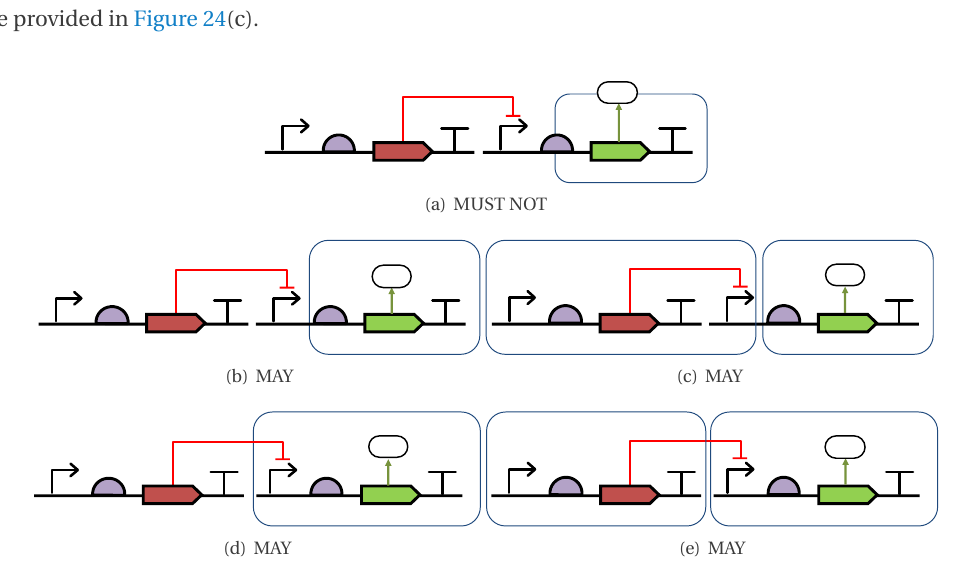
Figure 24: Examples of recommended and problematic boundary intersections: (a) sequence feature and molecular species glyphs MUST NOT intersect a subsystem boundary, (b) the repressed promoter and the regulated sequence elements in the subsystem are ordered to form a nucleic acid construct implementing a complete functional unit, (c) the promoter in the left subsystem and the regulated elements in the right subsystem are ordered to form a nucleic acid construct implementing a complete functional unit, (d) Interaction in which the CDS inhibits the promoter in the subsystem (presumably via a repressor product), (e) Interaction in which the CDS in the left subsystem inhibits the promoter in the right subsystem (presumably via a repressor